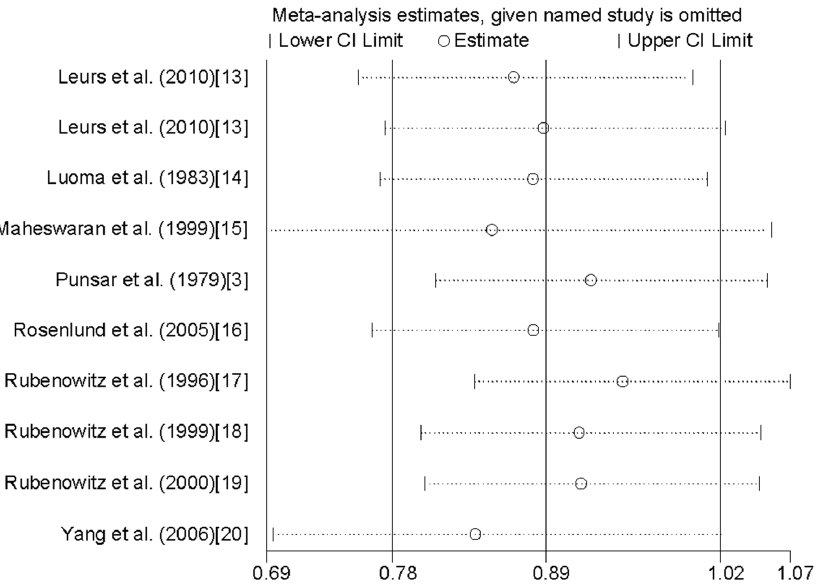
Figure 3. Analysis of influence of individual study on the association between the levels of